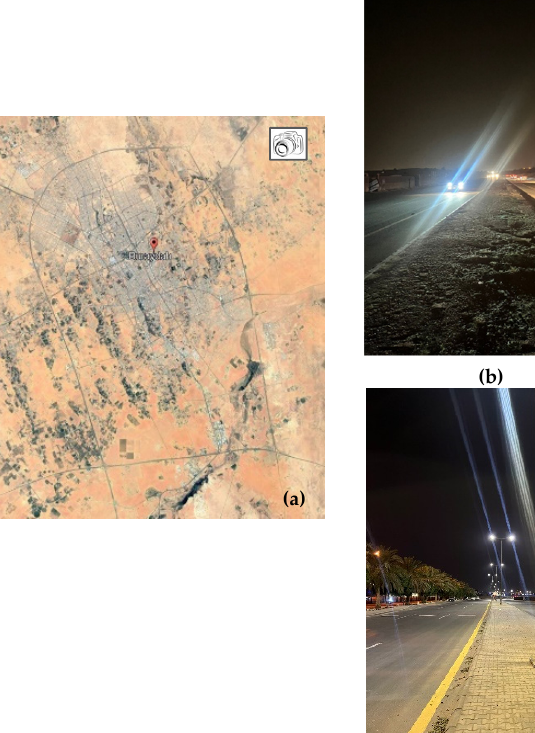
Figure 1. Vignette of urban street lighting performance appraisal framework.